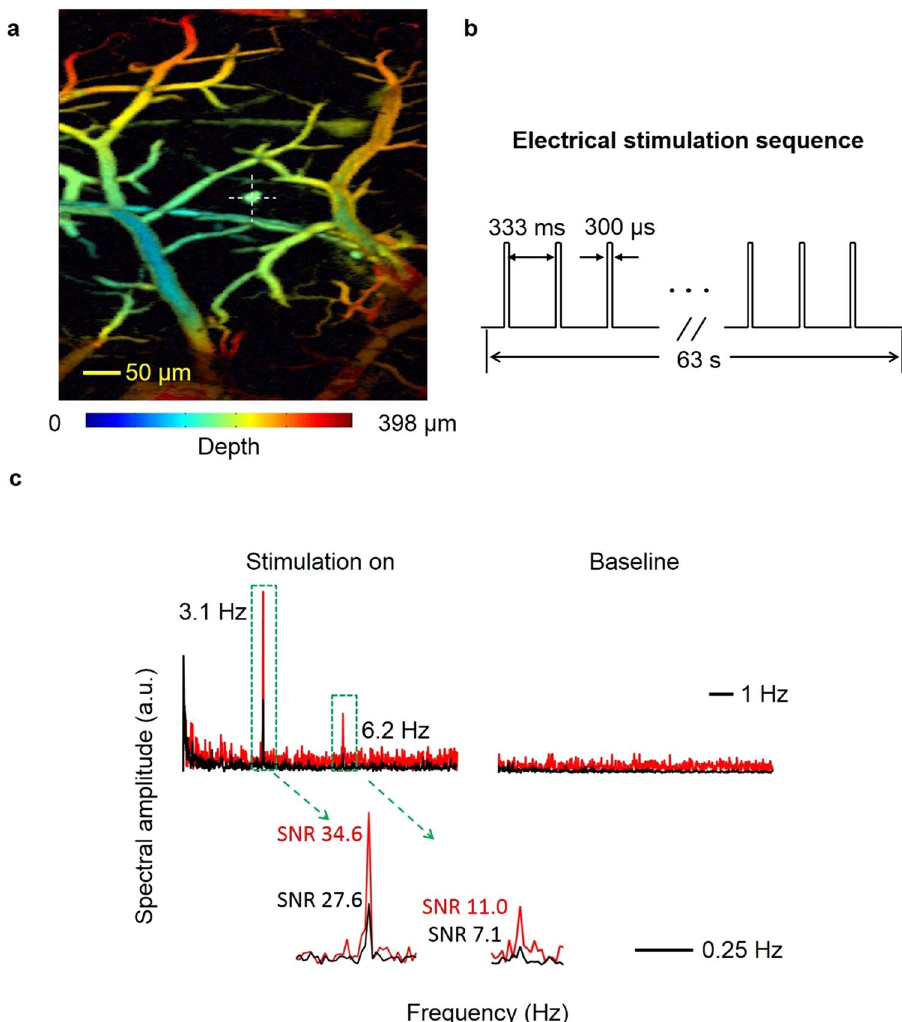
Figure 2. In vivo mouse brain response before and during electrical stimulation at a minimally vascularized point. ( a ) The exact M-mode imaging location is identified by the yellow cross in the depth-coded maximum amplitude projection image of the DPA-stained mouse cranial window. ( b ) A 63 second stimulation sequence comprises 189 electrical stimulation pulses with a pulse width of 300 μ s and a pulse period of 333 ms. ( c ) Baseline (before electrical stimulation) and response (during stimulation) of voltage and hemodynamic signals in the frequency domain. Both the voltage response signal (red) and hemodynamic response signal (black) have observable frequency components at 3.1 Hz and 6.2 Hz. The SNRs of the voltage and hemodynamic response peaks are respectively labeled with red and black